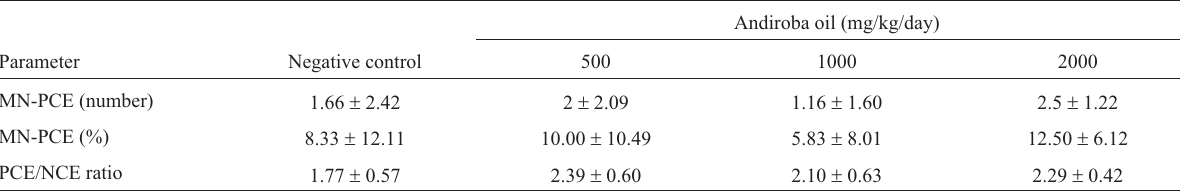
Table 4 - Frequency of micronuclei after treatment with andiroba